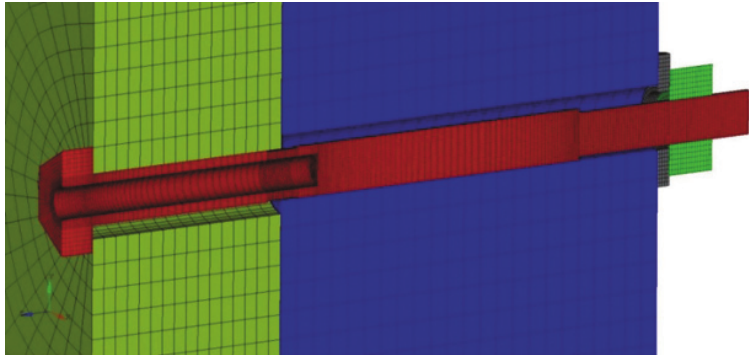
Fig. 5. Section view of finite element model, static shear test.